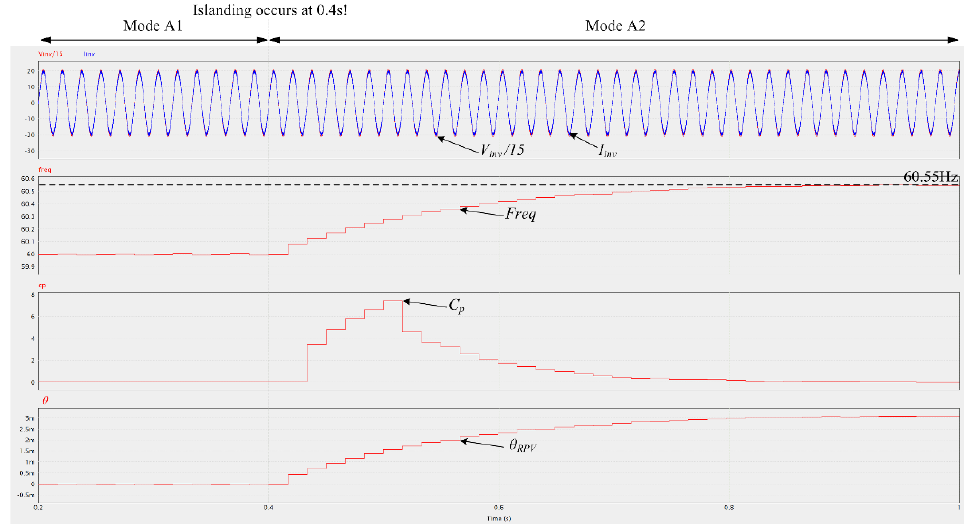
Figure 5. Anti-islanding test results for the proposed method without tripping.